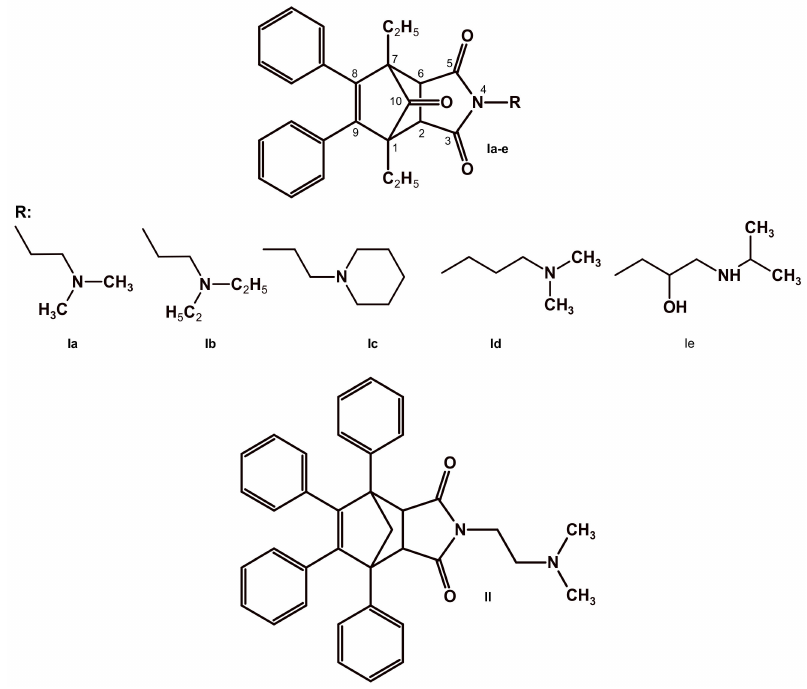
Figure 1. Structures of lead compounds Ia – e and II